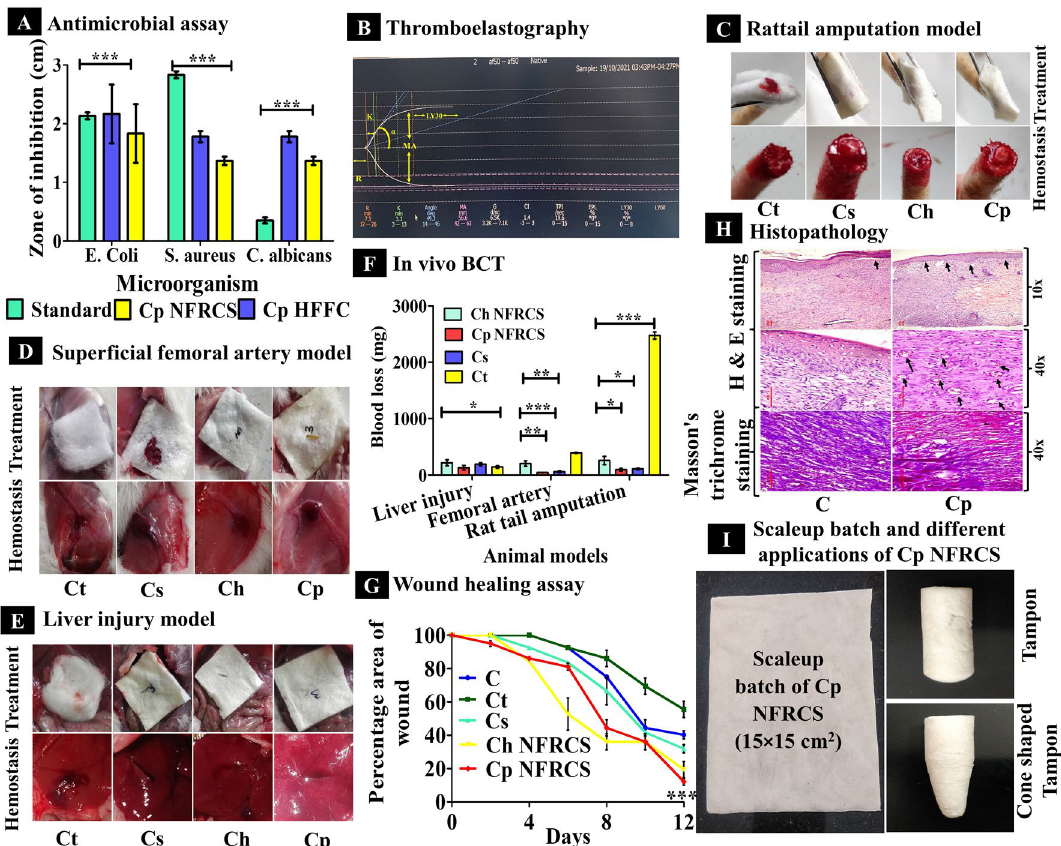
Figure 6. Various in vitro and in vivo characterization studies of NFRCS. ( A ) The graph represents the Cp HFFC and Cp NFRCS antimicrobial activity against three different micro-organisms. ( B ) Represents the N-TEG system-generated graph of Cp HFFC, which shows a reduction in R-value, indicating the quick initiation of blood coagulation in the presence of 10 µL Cp HFFC. ( C, D , E ) Represent the images captured during treatment and hemostasis after placing dressing material of various samples during in vivo BCT of tail amputation, superficial femoral artery, and liver injury model, respectively. ( F ) The graph represents the BCT of NFRCS in all animal models. ( G ) The graph represents the comparative wound healing profile of C, Ct, Cs, Ch NFRCS, and Cp NFRCS on the excision wound model; Cp NFRCS showed the best wound closure percentage (12.22 ± 0.25%) compared to other samples. ( H ) Represents the micrographs of C (control) and Cp NFRCS (showed better healing progress) stained by H&E and Masson’s trichrome staining. Epidermis and blood vessels formation was seen in Cp NFRCS treated group, and mature collagen formation was observed in Cp NFRCS by Masson trichrome staining. ( I ) The images represent the scale-up batch of Cp NFRCS (15 × 15 cm 2 ),